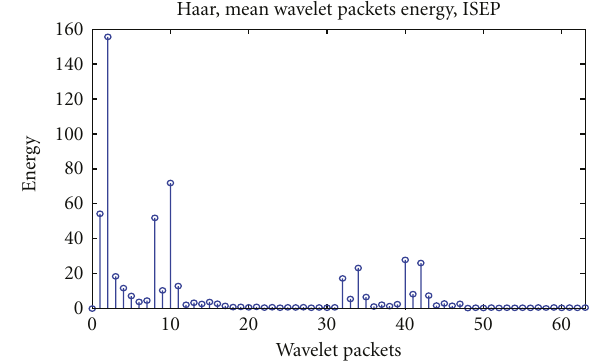
Figure 10: Mean wavelet-packet energy